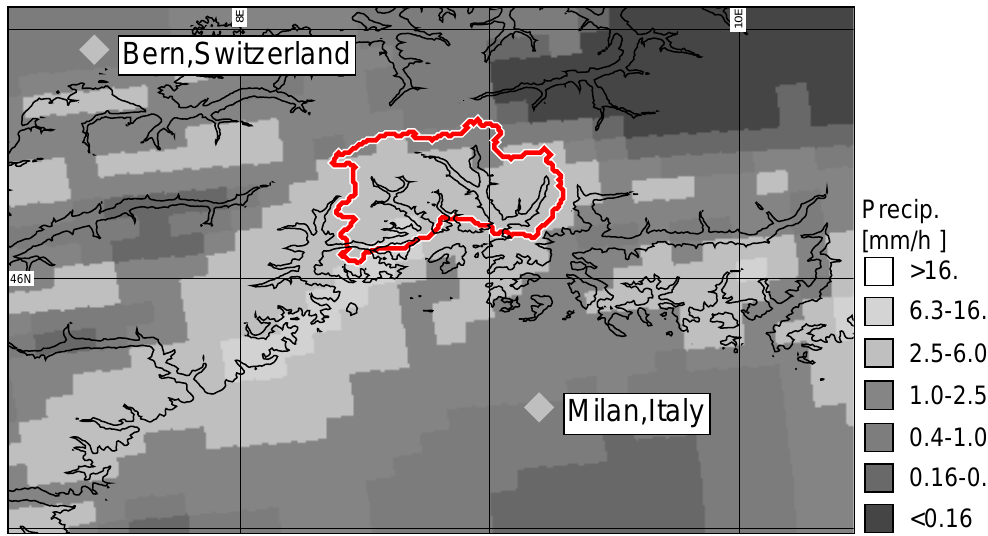
Fig. 10. Same as Fig. 1, but a precipitation field with grid spacing of about 10km simulated by ALADIN-VIENNA is shown for the period 06:00UTC at 20 September 1999 to 06:00UTC the next day.